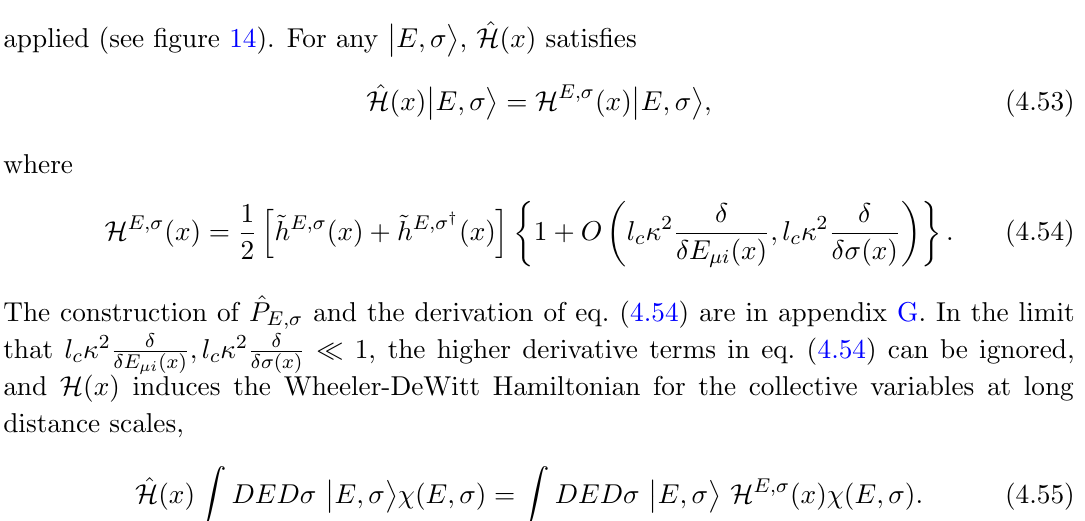
(cid:12) (cid:11) is applied by ^ H ( x ; E; (cid:27) ) which (cid:12) E; (cid:27)